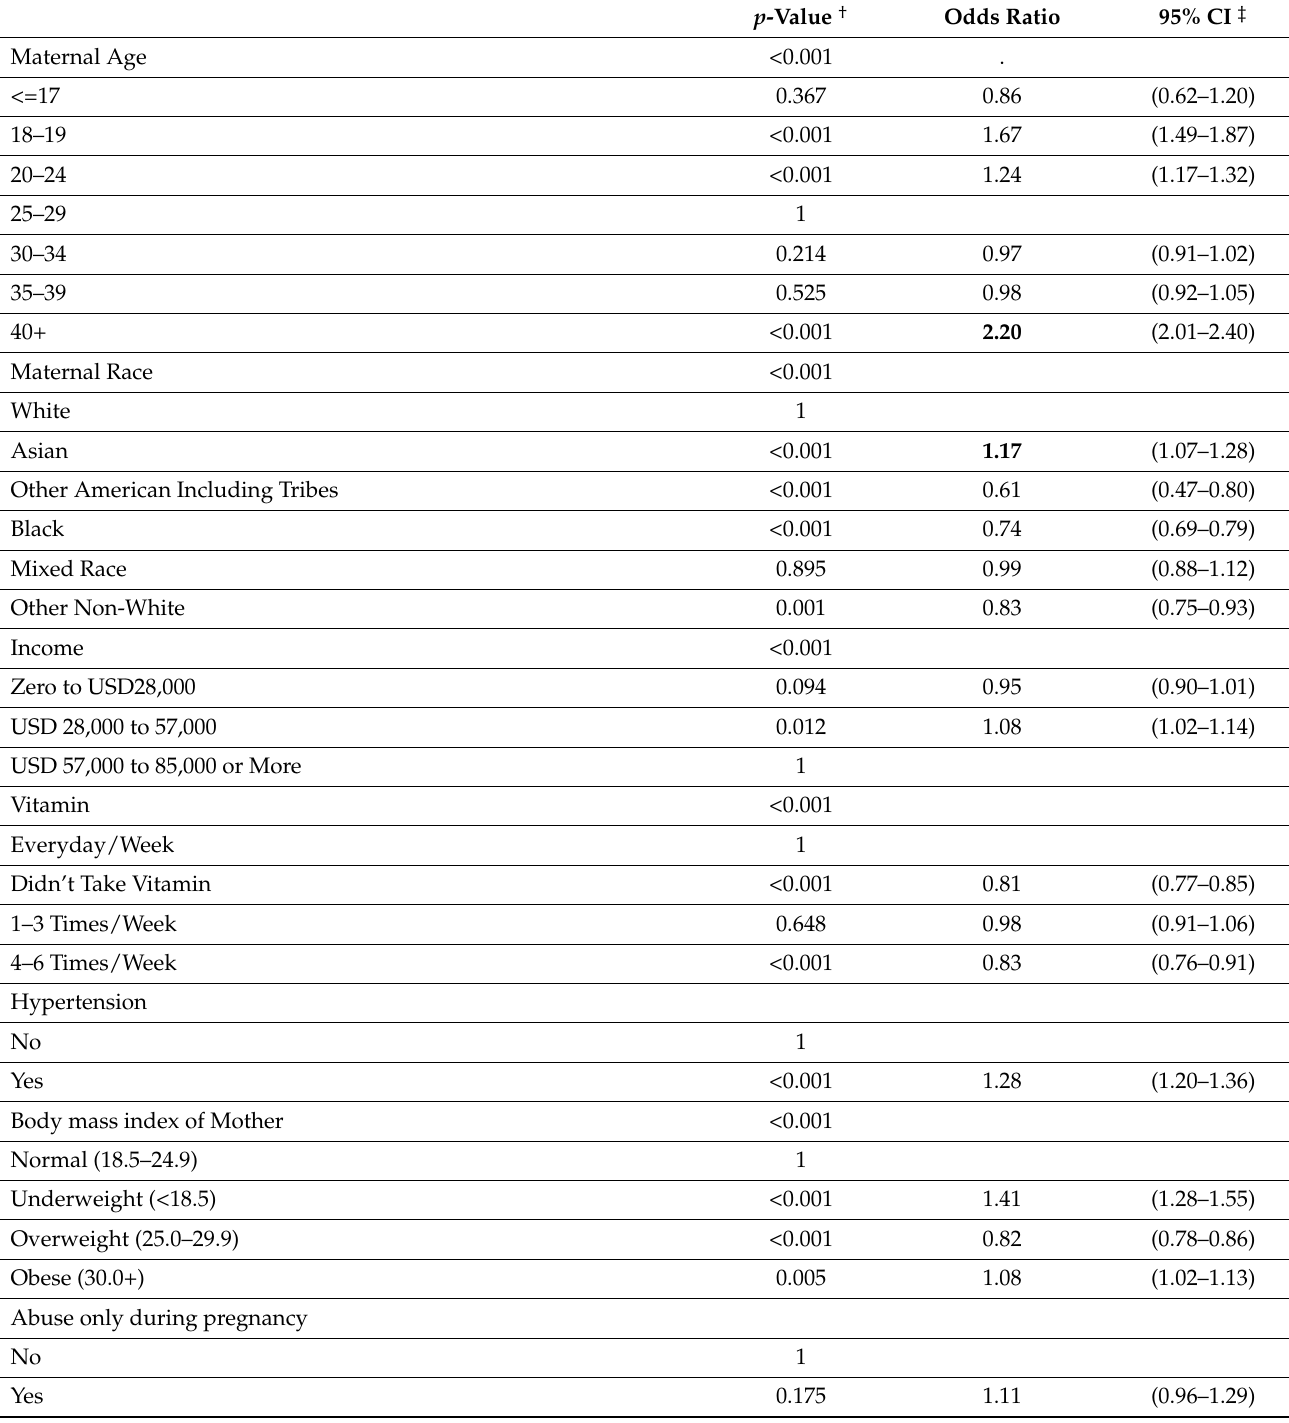
Table 2. The risk evaluation of smoking, diabetes, and depression during pregnancy on birth defects, United States,